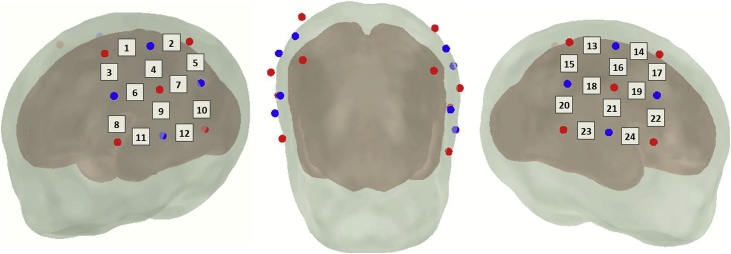
Optode placement overlaid on a schematic newborn head. Red dots indicate sources, blue dots indicate detectors, and numbers correspond to measurement channels (For interpretation of the references to colour in this figure legend, the reader is referred to the web version of this article).